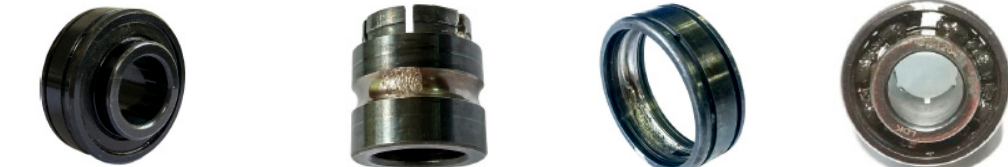
Figure 6. Images of typical bearing failure types.